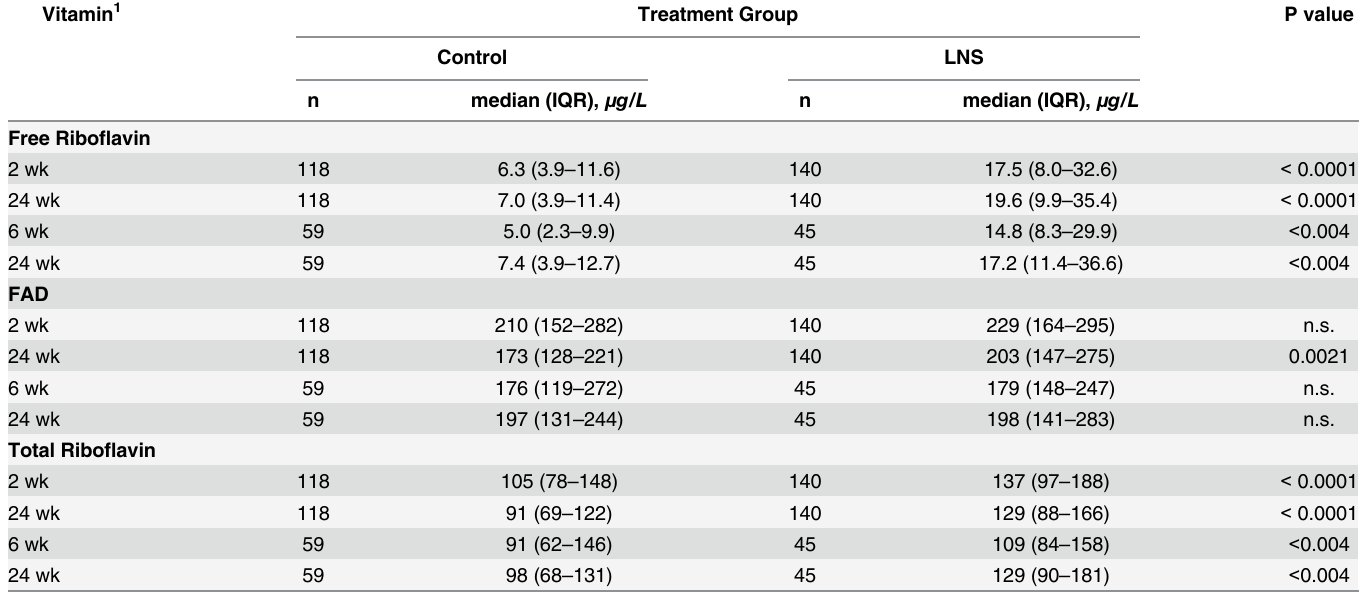
Table 5. Median concentration and interquartile range of free riboflavin, FAD, and total riboflavin in breast milk of BAN study women assigned to one of two treatment arms within the two subgroups (initial sample at 2 or 6 weeks). Vitamin